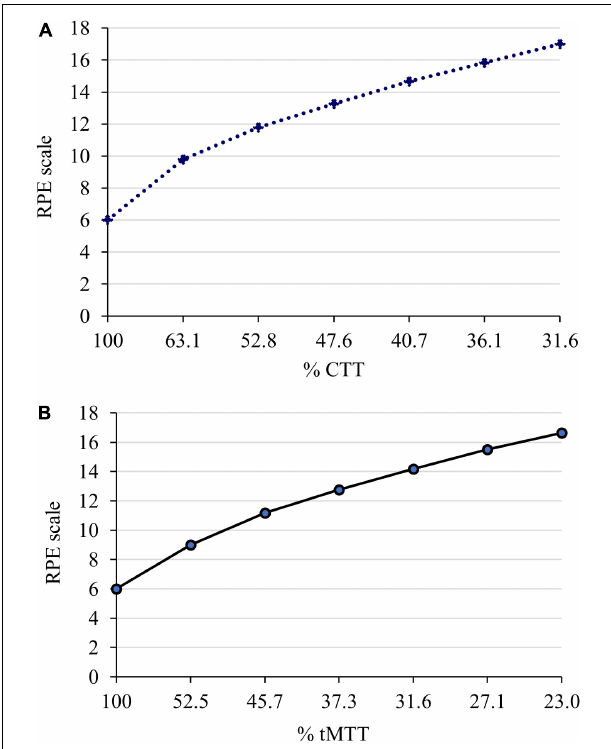
FIGURE 6 | Serial response of perceived exertion based on Borg’s 6 to 20 RPE scale during two sessions of incremental cardiorespiratory exercise with (A) the CTT and (B) the tMTT, respectively. The estimated exercise intensity (%CTT and %tMTT) decreased as the exercise progressed. 100%CTT and 100%tMTT indicate the baseline where RPE scale is the lowest, 6 as there is no exertion.